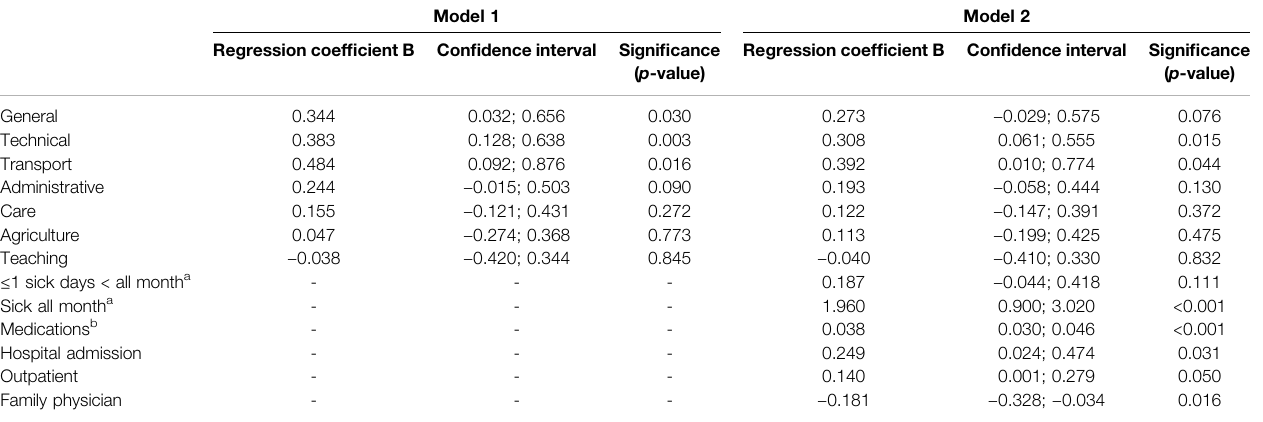
TABLE4| LinearregressionmodelsofLRPDonoccupationaldomain 1 ,adjustedforageandworkstatus(model1),andadditionallyadjustedfor fi vehealthvariables(models 2). Imputed data ( n (cid:1) 2,531) 2 . Source: Longitudinal Aging Study Amsterdam, 1992 – 93 to 2019.